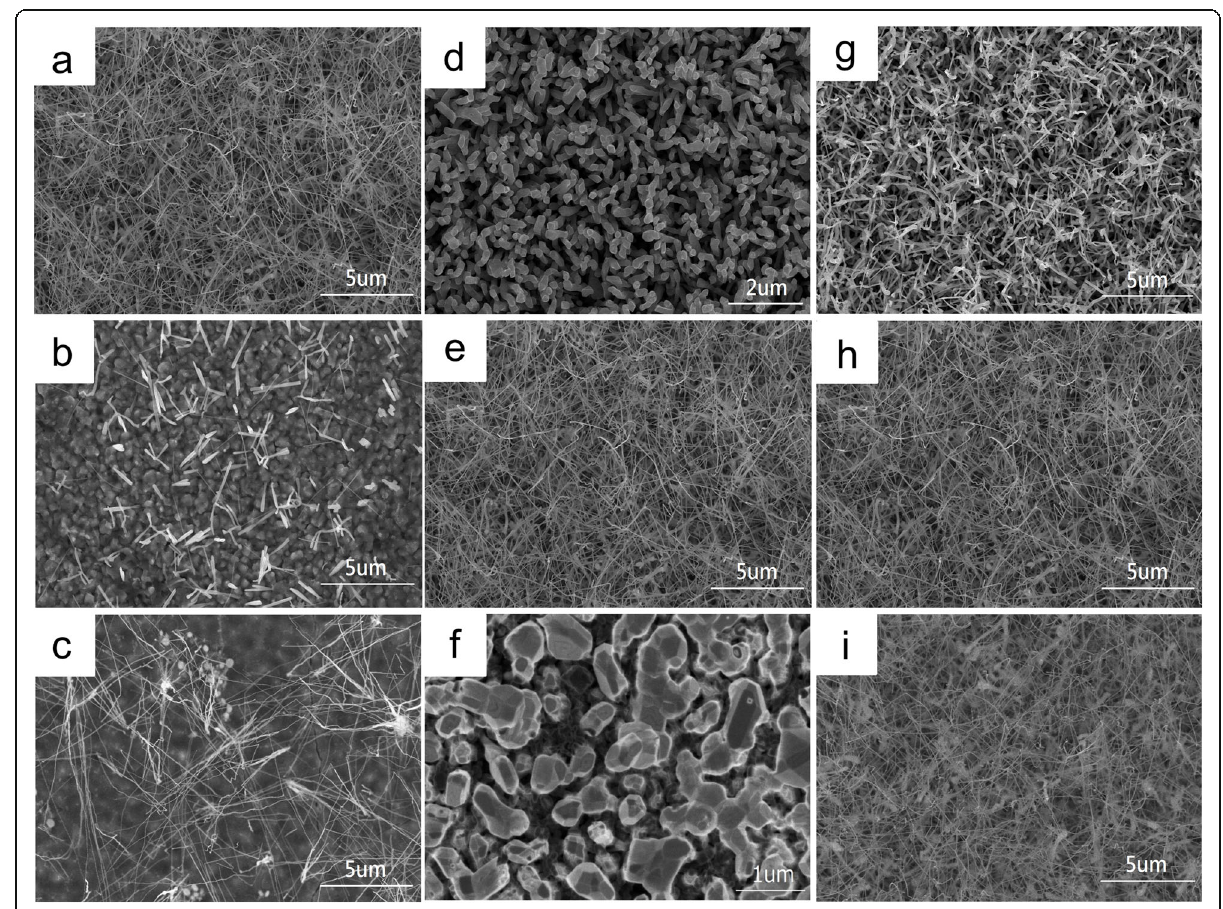
Fig. 1 SEM images of β -FeSi 2 nanowires at different parameters. At different gas flow rates: a 50 sccm, b 80 sccm, and c 120 sccm. At different temperatures: d 750 °C, e 850 °C, and f 950 °C. At different duration times: g 1 h, h 2 h, and i 5